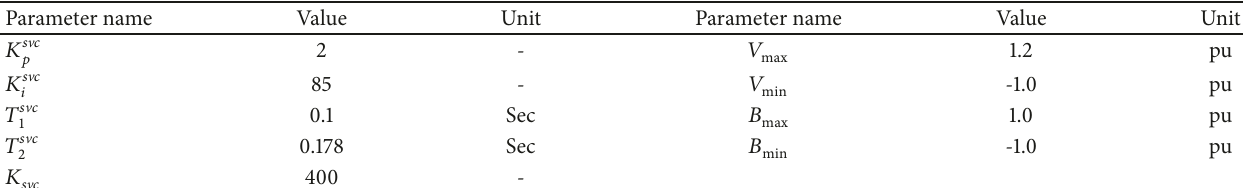
Figure 14: The control strategy for STATCOM. Table 2: The parameters of SVC control system.